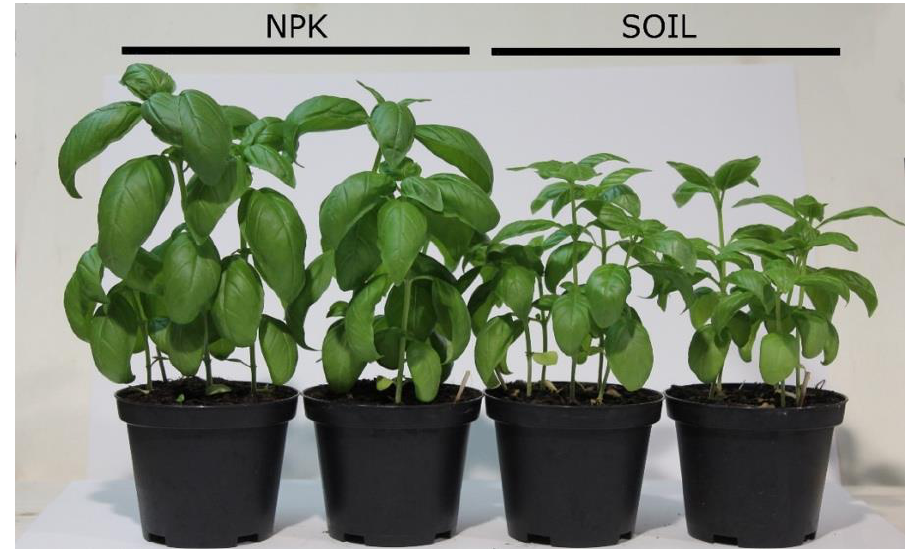
Figure 7. Basil plants obtained under 1HR:3DB LED lights.